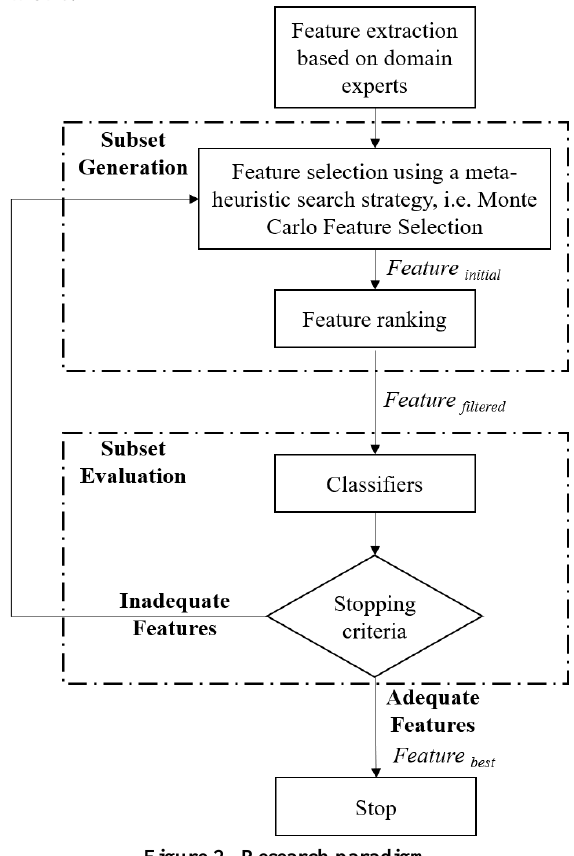
Figure 2. Research